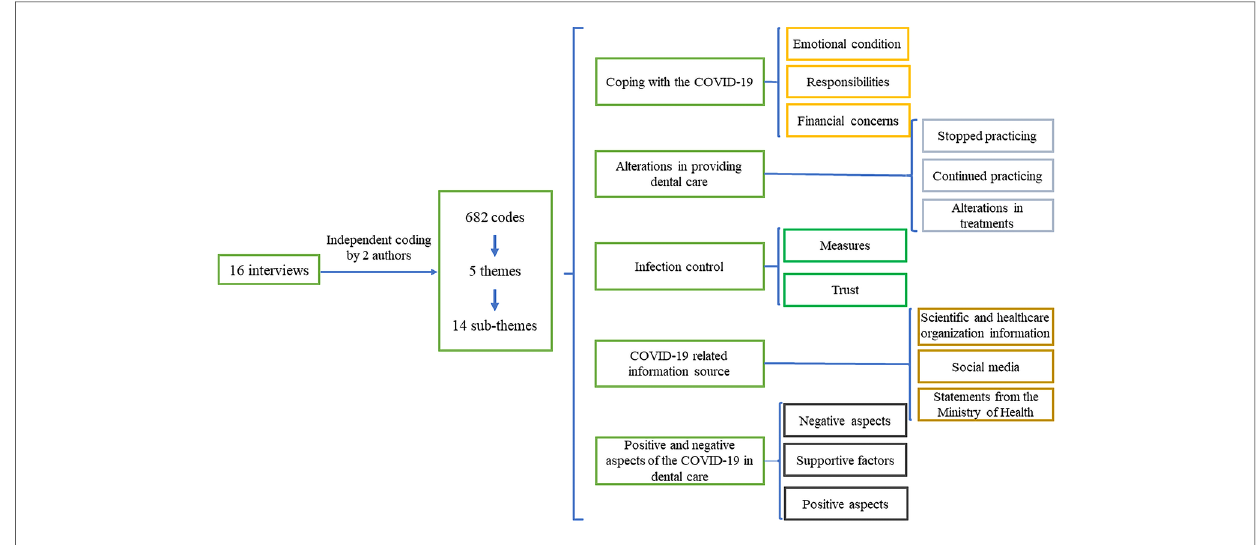
FIGURE 1 The study fl ow diagram containing the main themes and